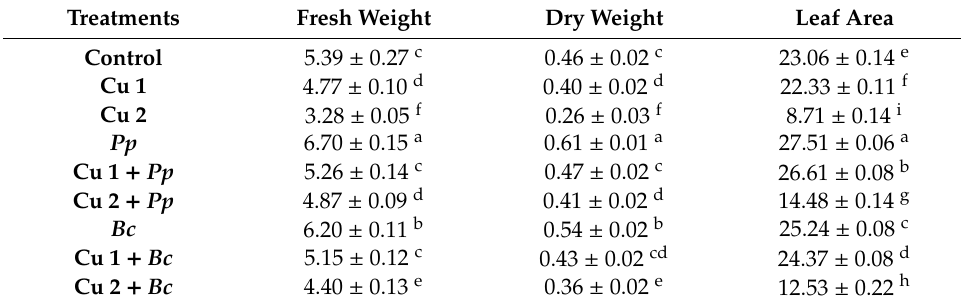
Table 1. E ff ects of bacterial inoculation under copper stress on fresh weight (g plant − 1 ) (b) dry weight (g plant − 1 ) and (c) leaf area (cm 2 plant − 1 ) in maize plants. Bars represent the standard deviation ( ± SD) of the means ( n = 3). Di ff erent letters indicate significant di ff erences among the treatments at p < 0.05, according to Duncan’s multiple range test. The treatments include Control, plants without copper stress and bacterial strains inoculation; Cu 1: plants exposed to 100 µ M CuSO 4 ; Cu 2: plants exposed to 500 µ M CuSO 4 ; P. polymyxa ( Pp ) inoculated plants without CuSO 4 ; Cu 1 + Pp : plants exposed to 100 µ M CuSO 4 and inoculated with P. polymyxa ; Cu 2 + Pp : plants exposed to 500 µ M CuSO 4 and inoculated with P. polymyxa ; B. circulans ( Bc ) inoculated plants without CuSO 4 ; Cu 1 + Bc : plants exposed to 100 + Bc : plants exposed to 500 µ M CuSO µ M CuSO 4 and inoculated with B. circulans and Cu 2 4 and inoculated with B. circulans